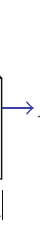
Figure 3: Flux in equals flux out for the control volume.